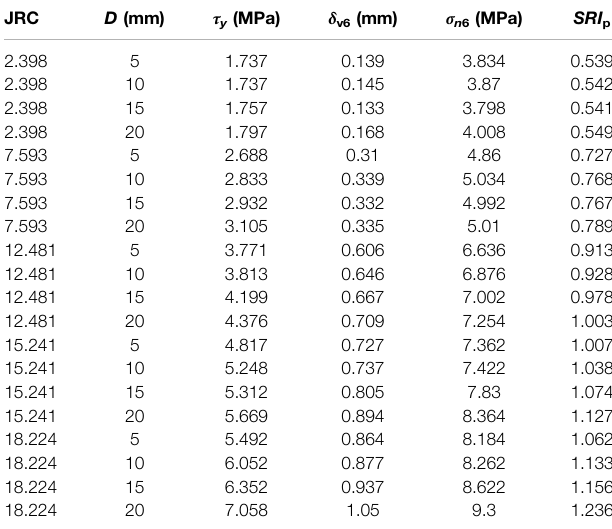
TABLE 3 | Summary of τ y , δ v 6 , σ n 6 , and SRI p